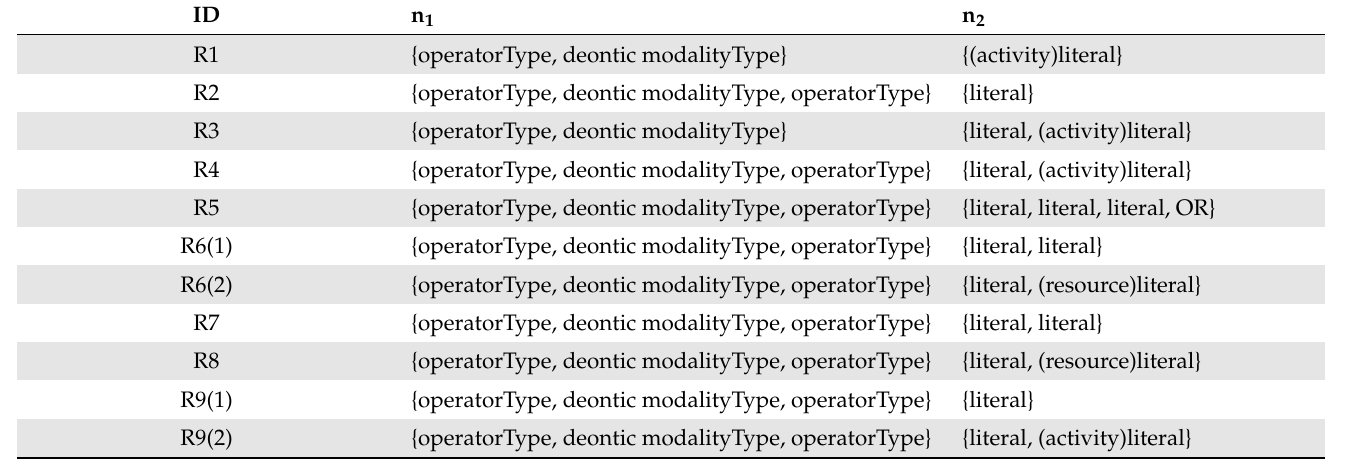
Table A9. Definitions on PCL